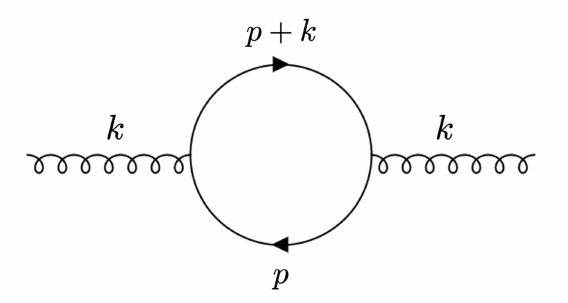
Figure 1. 1-loop correction to the graviton propagator relevant to the induction of the gravitational Chern-Simons